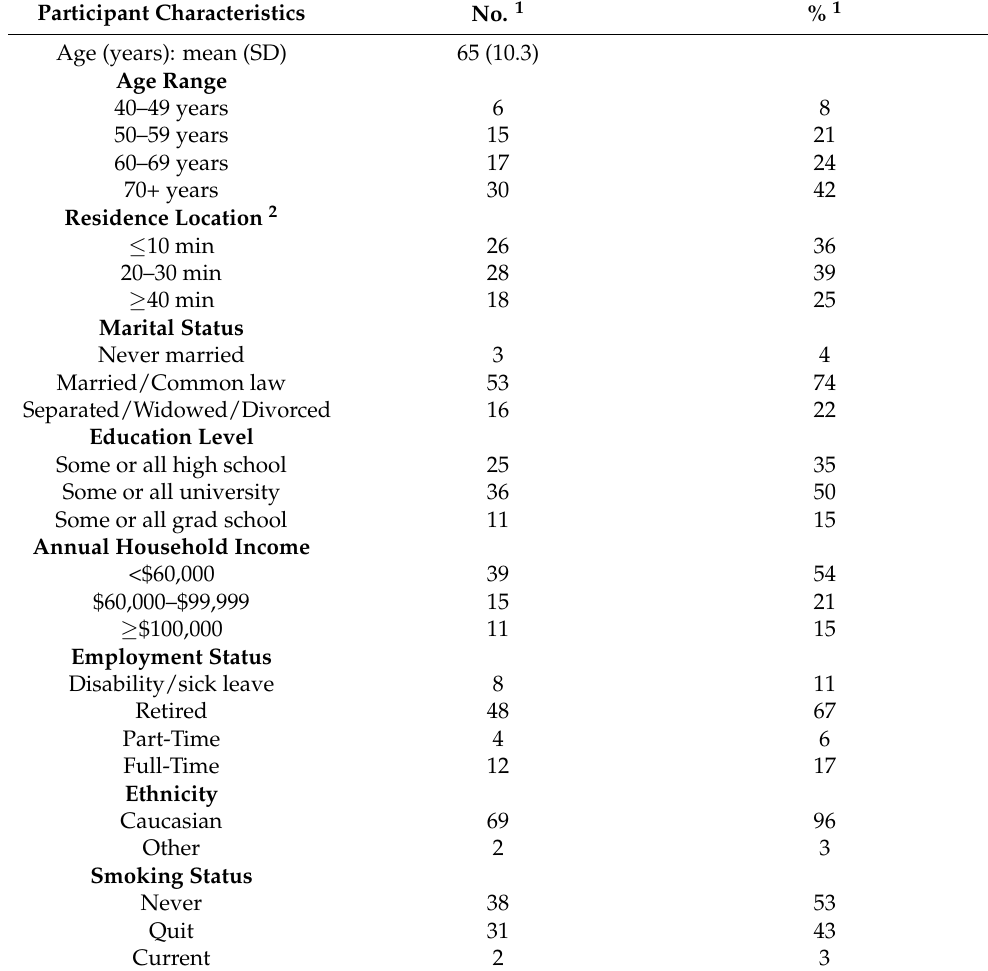
Table 1. Participant demographics (total n =